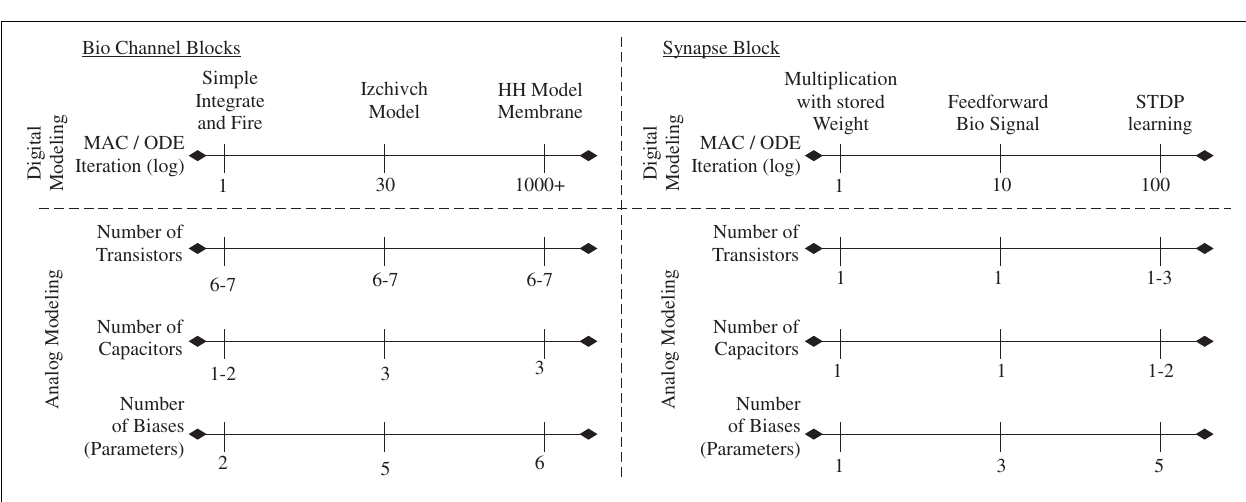
devices). Although the moving from an integrate and fire neuron to a HH based neuron might be a difference of 1000 in computational complexity for digital approaches, the difference in transistor, capacitor, or bias count is very small for physically implemented